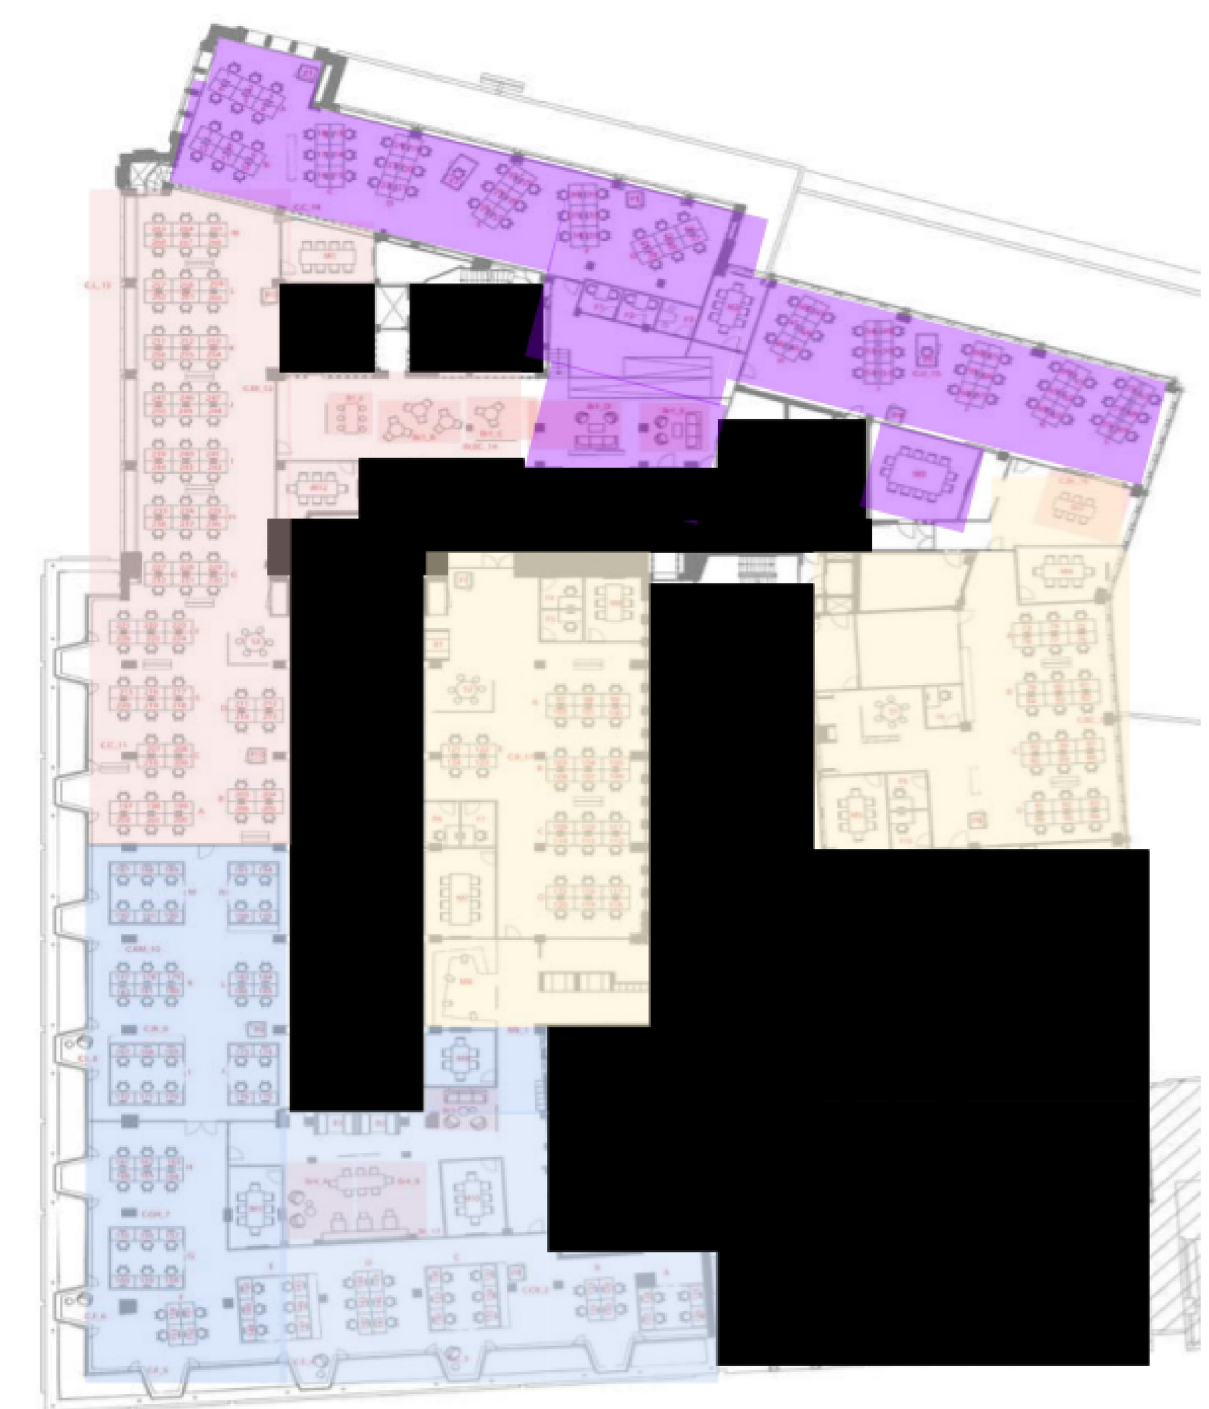
Fig 2. Floorplan of the experimental floor. Blacked out areas represent empty spaces (e.g. atriums) and non-experimental areas. Coloured areas represent experimental zones Control (red), Limited open plan (purple), Zoned open plan (yellow), and Team offices (blue).